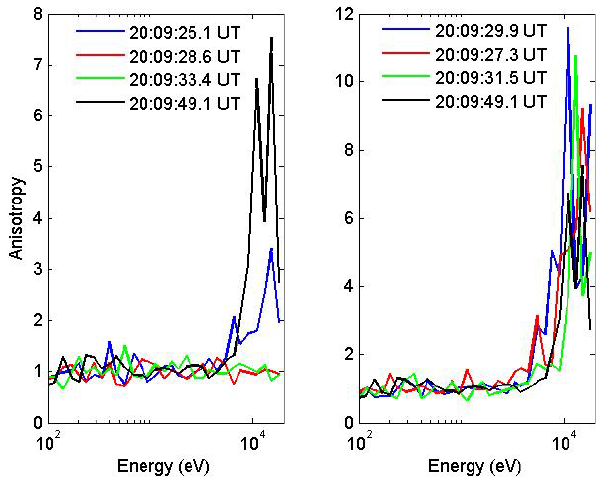
Fig. 10. The anisotropy coefficients as a function of energy. The left plot corresponds to regions inside the auroral stripes, the right plot corresponds to regions between the stripes. In both plots the black line shows the anisotropy coefficients in the region of weak